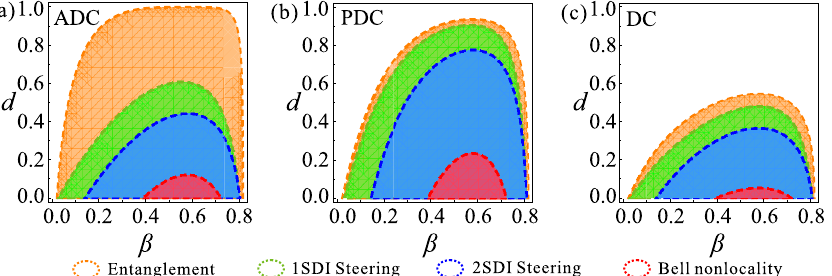
Figure 2. The dynamics of various genuine tripartite nonlocal quantum correlations under ADC ( a ), PDC ( b ), and DC ( c ). The regions enclosed by the orange dashed curves, green dashed curves, blue dashed curves and red dashed curves correspond to the existence of genuine tripartite entanglement, 1SDI genuine tripartite steering, 2SDI genuine tripartite steering, and genuine tripartite Bell nonlocality,